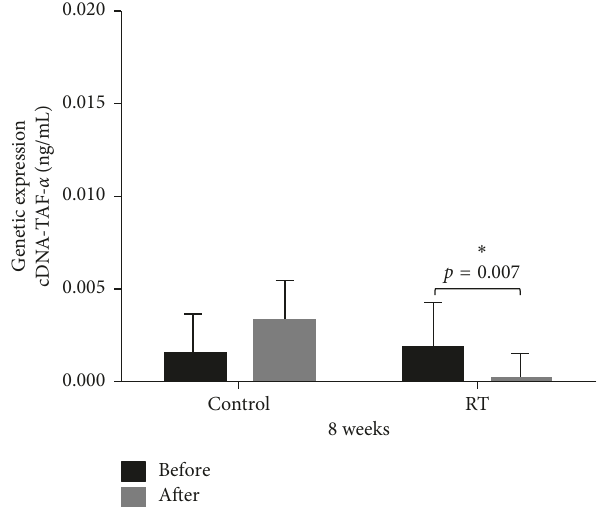
Figure 4: Measurements of tumor necrosis factor- α gene ex- pression between Control ( n � 4) and RT ( n � 5) groups at Pre and Post moments. Two-way ANOVA test: ∗ statistically significant difference ( p � 0 . 007) between Pre and Post moments in the RT group.